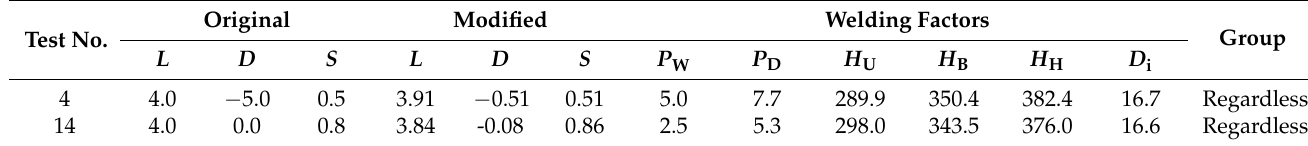
Table 13. Results of welding parameters modified by optimization process.